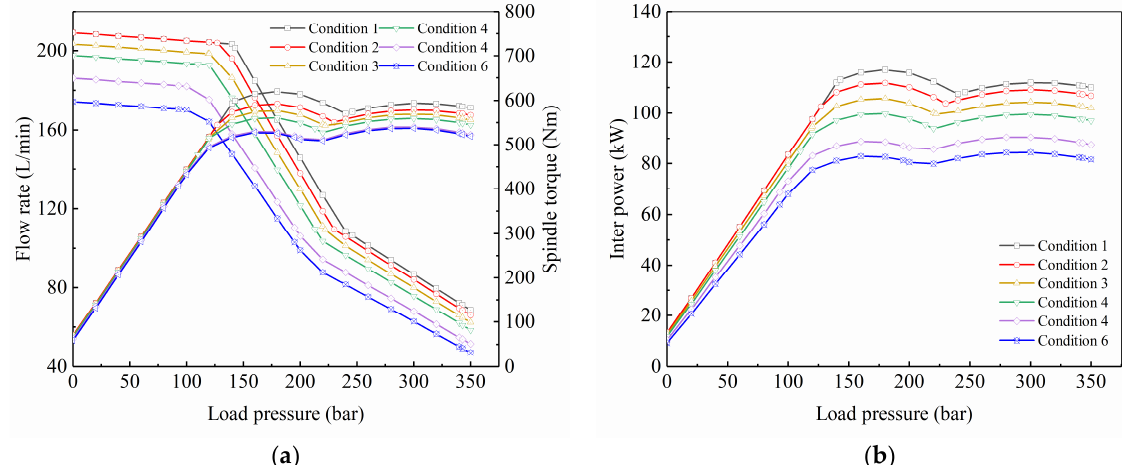
Figure 16. Constant power control curves of the double-compound axial piston pump under different working conditions: ( a ) outlet flow and spindle torque; ( b ) input power.